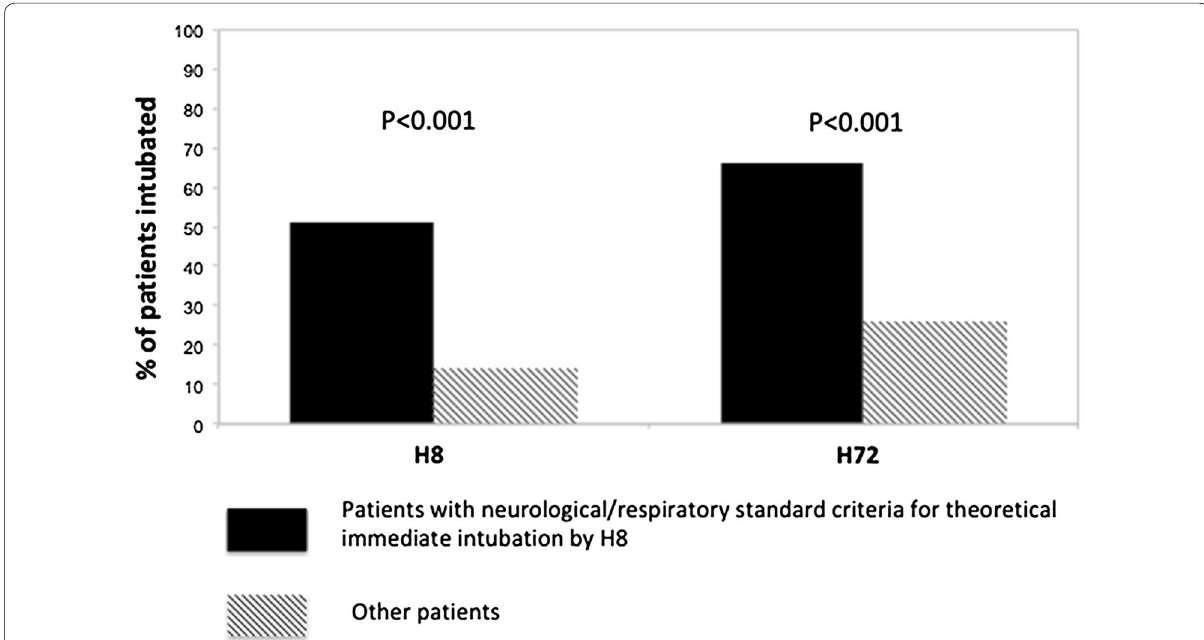
Fig. 3 Intubation frequency at H8 and H72 in patients with and without neurological or respiratory standard criteria for theoretical immediate intubation by